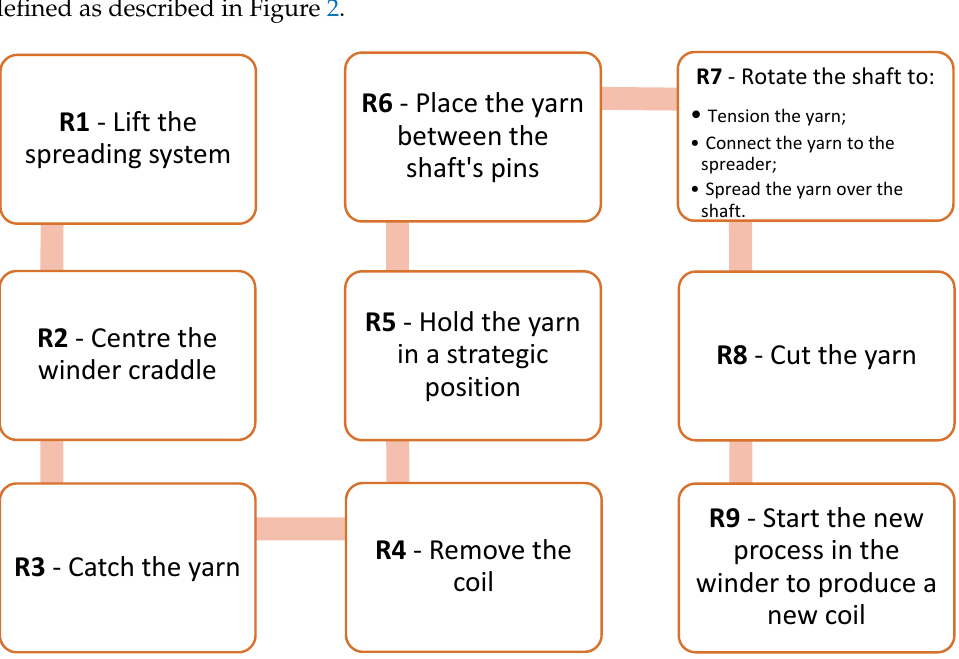
Figure 1. Manual process for obtaining a yarn coil.